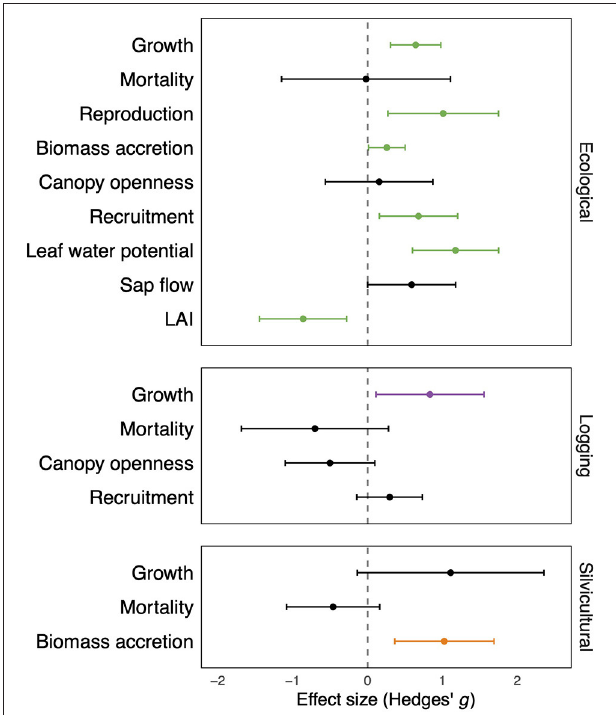
FIGURE 2 | Tree responses to liana removal experiments conducted in tropical and subtropical forests in published ecological, logging, and silvicultural studies. Values are standardized effect sizes (Hedges’ g ) and their 95% confidence intervals estimated by three-level meta-analytic models. Values greater than zero indicate positive effects of liana removal. Green, purple, and orange values represent significant differences from zero; black values represent non-significant differences from